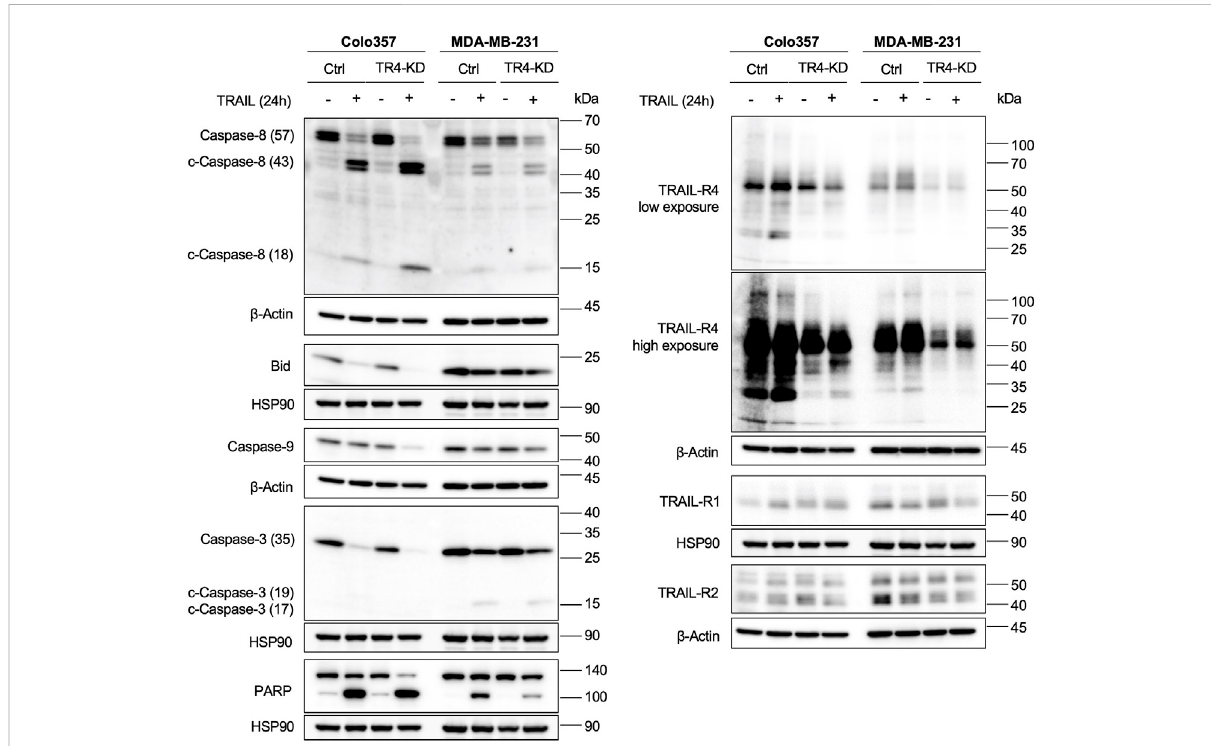
FIGURE 5 Knockdown of TRAIL-R4 impacts TRAIL-mediated apoptosis of Colo357 and MDA-MB-231 cells in an opposing manner. Colo357 and MDA- MB-231 control (Ctrl) and TRAIL-R4-knockdown (TR4-KD) cells were seeded at 3,3 × 10 5 /well (Colo357) and 3 × 10 5 /well (MDA-MB-231) in 6-well formatand24 hlaterwerestimulatedwithTRAIL(Colo357 – 50 ng/ml;MDA-MB-231 — 100 ng/ml)for24 horleftuntreated.Whole-celllysateswere analyzedbyWesternblotforthelevelsofCaspase-8,Bid,Caspase-9,Caspase-3andPARP.Detectionofeither β -ActinorHSP90servedasagel loading control. Shown are representative pictures from one related experiment out of at least three biological